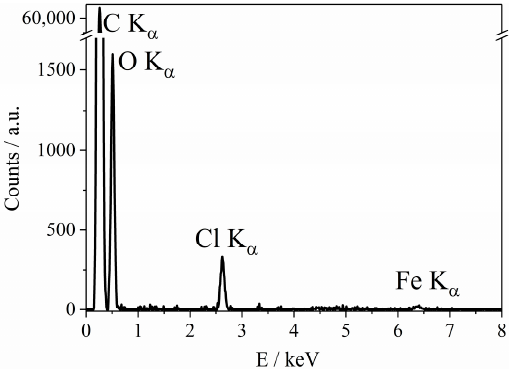
Figure 2. Energy dispersive X-ray (EDX) spectra of a PB nanoparticle-modified carbon screen-printed electrode (Prussian blue content 2.15 mg/g).